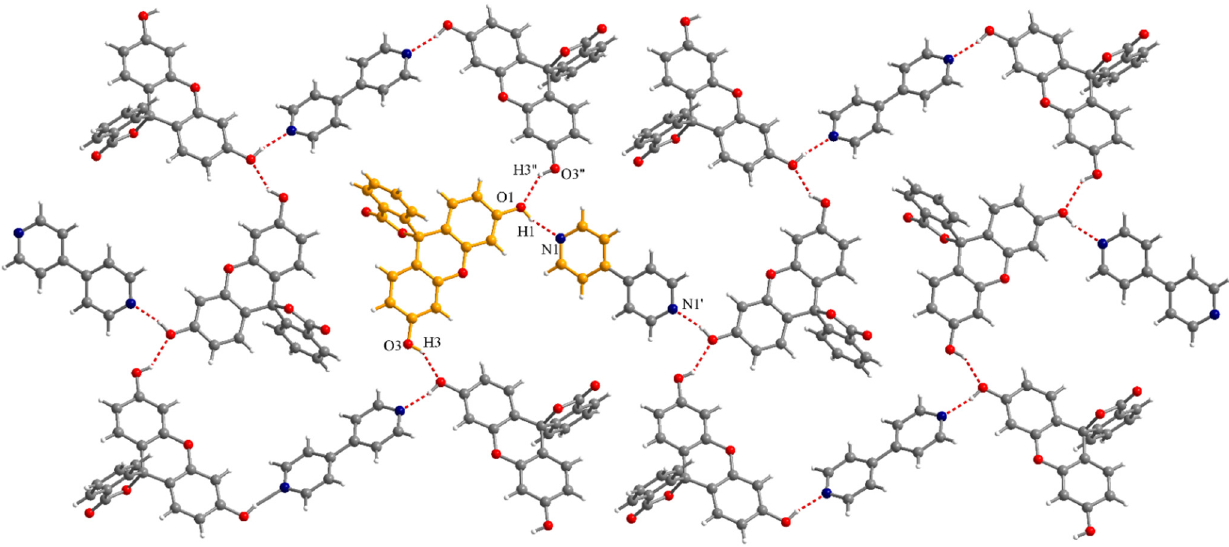
Figure 2. View of the 2D supramolecular array formed through hydrogen interactions in crystal 1 . Symmetry codes: ’ = 1 − x, 1 − y, − 1 − z; ” = 0.5 − x, − 0.5+y, − z.